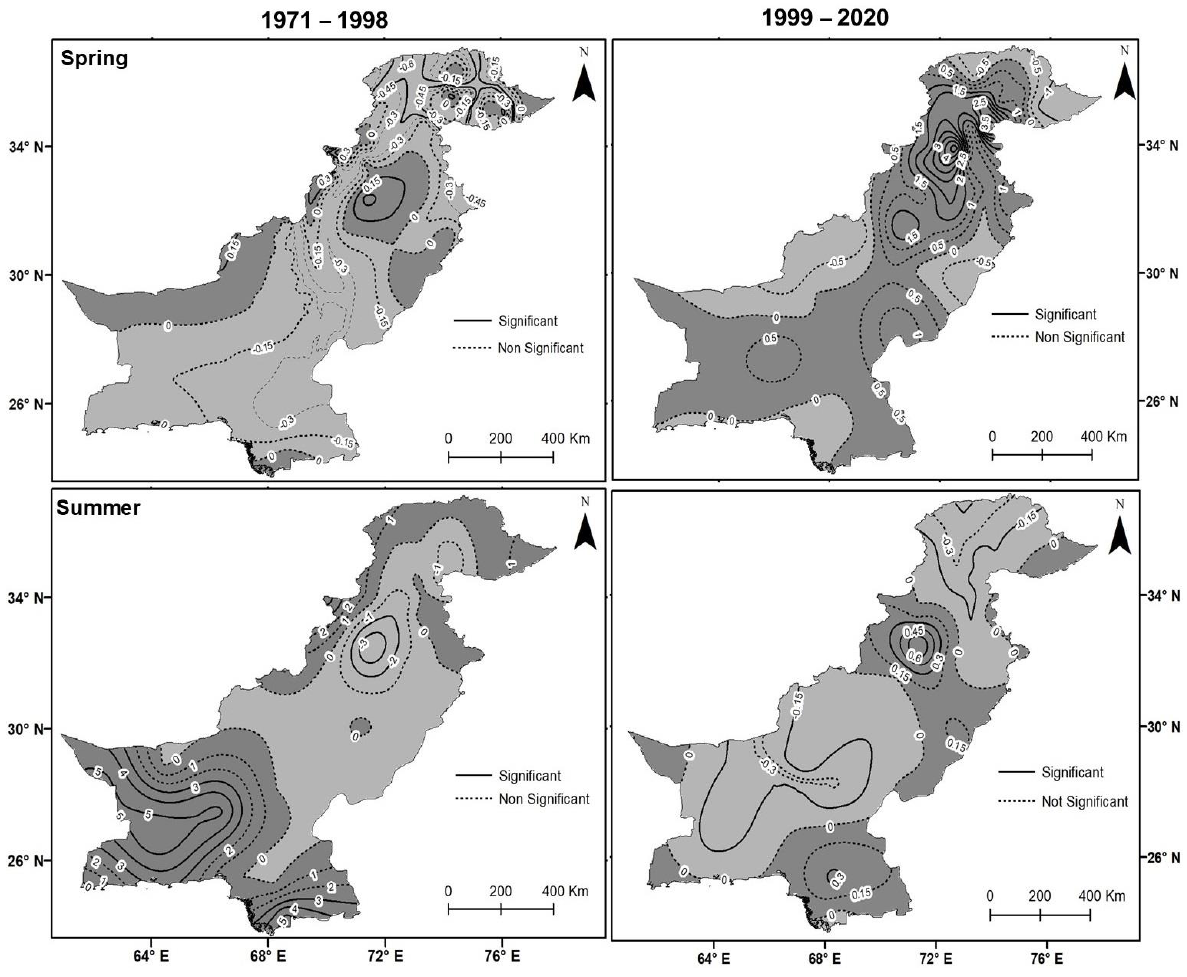
Figure 3. Spatial variation of dry days (numbers)in spring and summer seasons between 1971 and 1998 as well as 1999 and 2020. Dark color indicates the positive changes and light color shows the negative changes at 0.05 level of significance. Figure 4 indicates the trends of wet days in the spring and summer monsoons. The wet days showed a significant decreasing trend (stronger from east to west regions than other regions) and increasing trends found in the northwest regions (Drosh, Chitral, and Gupis) in the 1st data period, whereas significantly increasing trend at significant level 0.05 observed in some pockets near eastern regions in the 2nd data period. Similarly, the